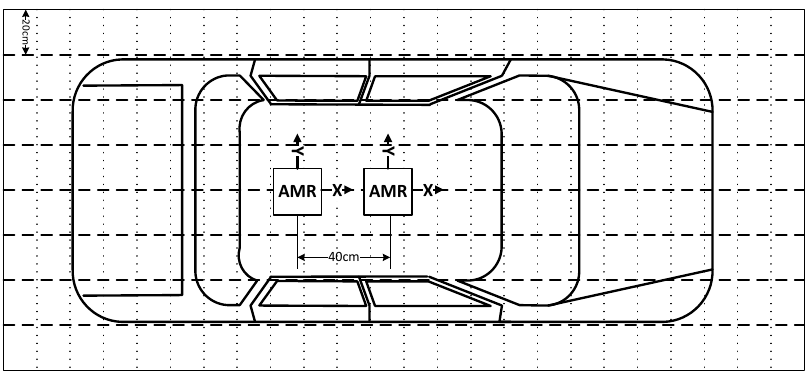
Figure 2. Vehicle scanning scheme.